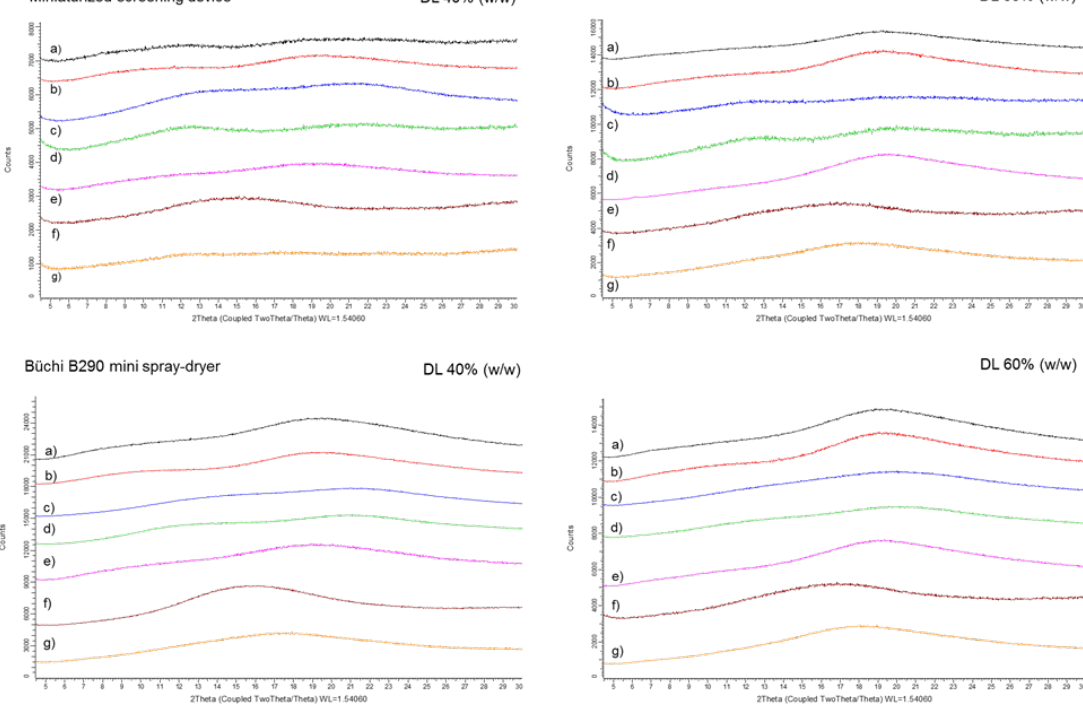
Figure 4. XRPD patterns of 40:60 and 60:40 ( w / w ) SDSDs of itraconazole with HPMCP HP50 ( a ), HPMCAS-LF ( b ), PVPVA ( c ), PVPK30 ( d ), Soluplus ( e ), Eudragit L100 ( f ), and Eudragit L100-55 ( g ) produced by the miniaturized screening device and Büchi B290 mini spray-dryer.